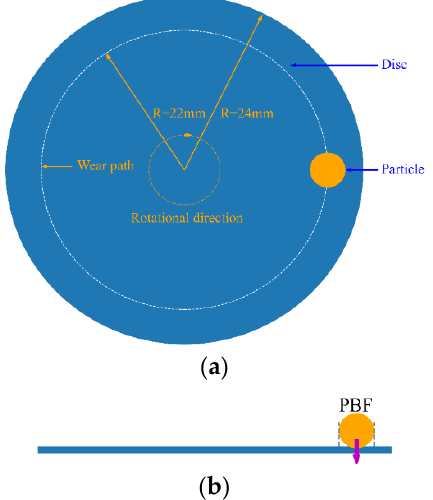
Figure 6. Pin-on-disc test setup. ( a ) Top view; ( b ) Side view.